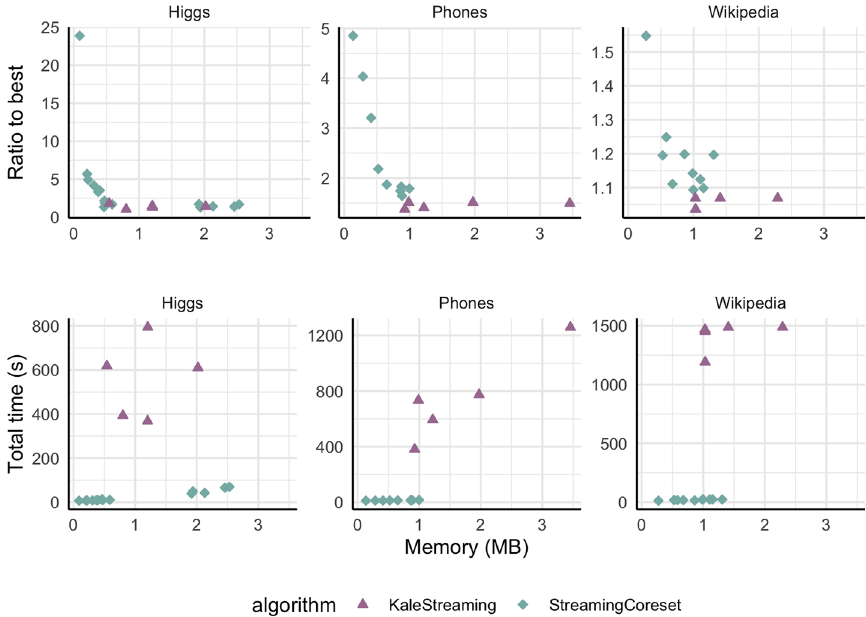
Fig. 3 Approximation ratio and total running time for S treaming C oreSet and K ale S tream against memory usage. The time scale is